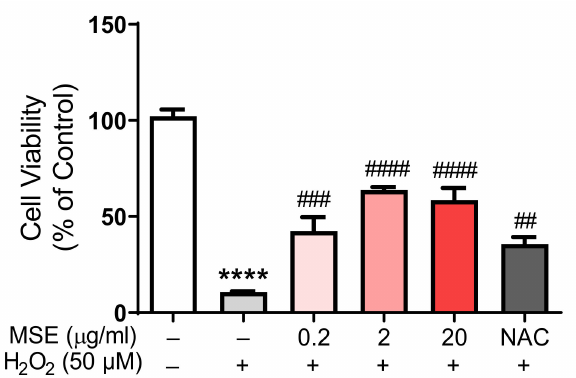
Figure 10. Protective effects of Maydis stigma extracts on cell viability in rat primary cortical neurons. MSE (0.2, 2, 20 µ g/mL)- and NAC (500 µ M)-treated in rat primary cortical neurons on DIV 8. After 24 h, 50 µ M of H 2 O 2 was added to the cultured neurons. MSE treatment prevented H 2 O 2 -induced neuronal cell death. **** p < 0.0001; Veh vs. H 2 O 2 . ## p < 0.01 , ### p < 0.001, #### p < 0.0001; H 2 O 2 vs. MSE and NAC (N =